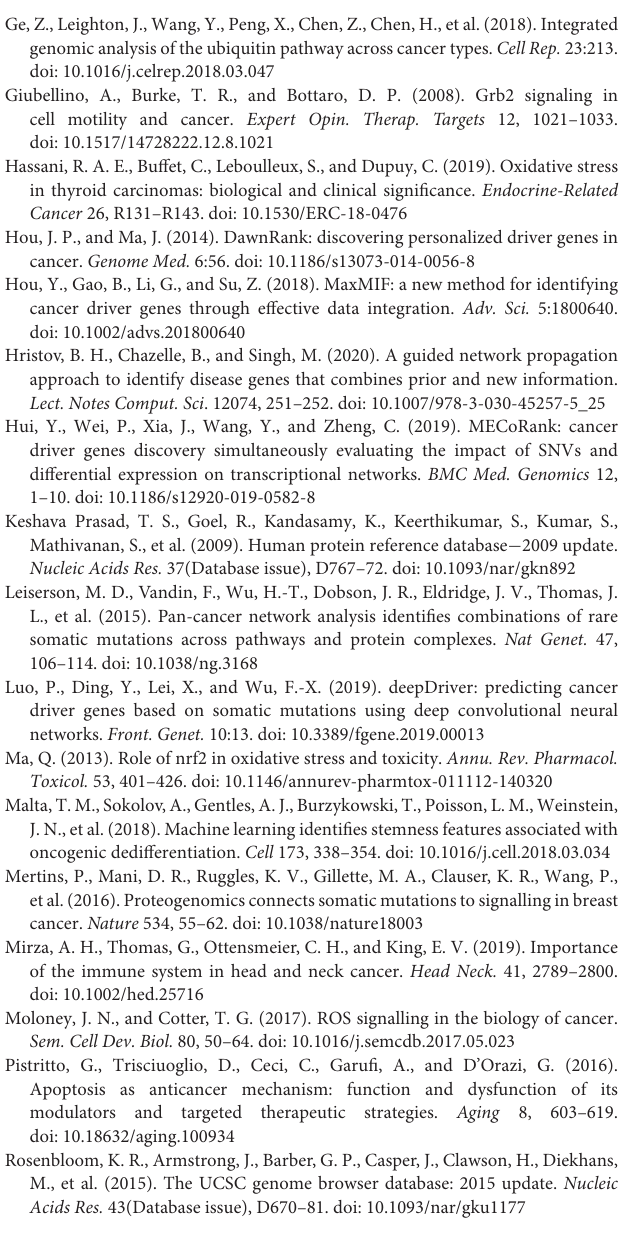
Supplementary Figure 1 | The top 10 gene ontology (KEGG) terms enrichment of (A) BRCA, (B) HNSC, (C) KIRC, and (D) THCA by significant genes with p < 0.05 in DriverSubNet. Supplementary Table 1 | The details of the dataset. Supplementary Table 2 | A list of top 100 candidate-driver genes of four